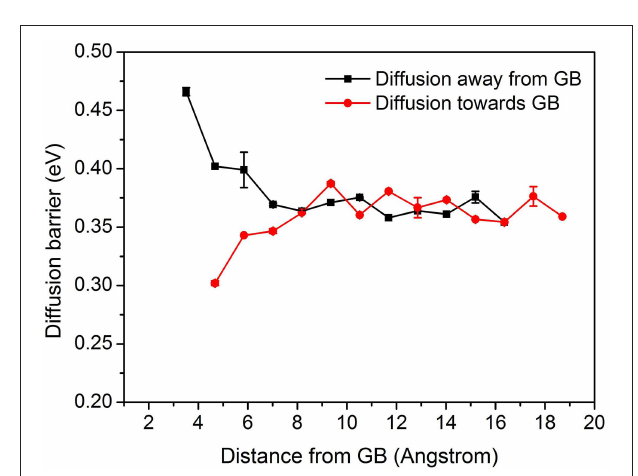
FIGURE 6 | Diffusion energy barrier of P 3{112}109.5 ◦ model as a function of distance from the GB, including diffusion away and toward the GB (Error bars denote the standard